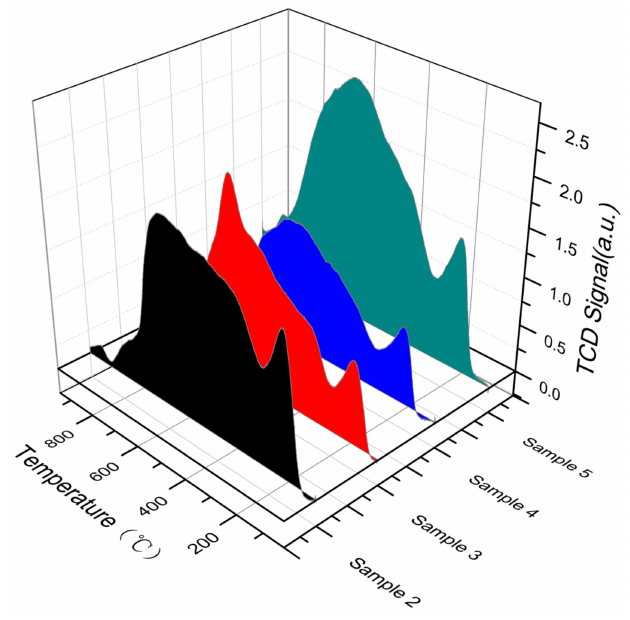
Figure 5. Characterization of NH 3 -TPD in rare earth concentrates subjected to di ff erent treatments.